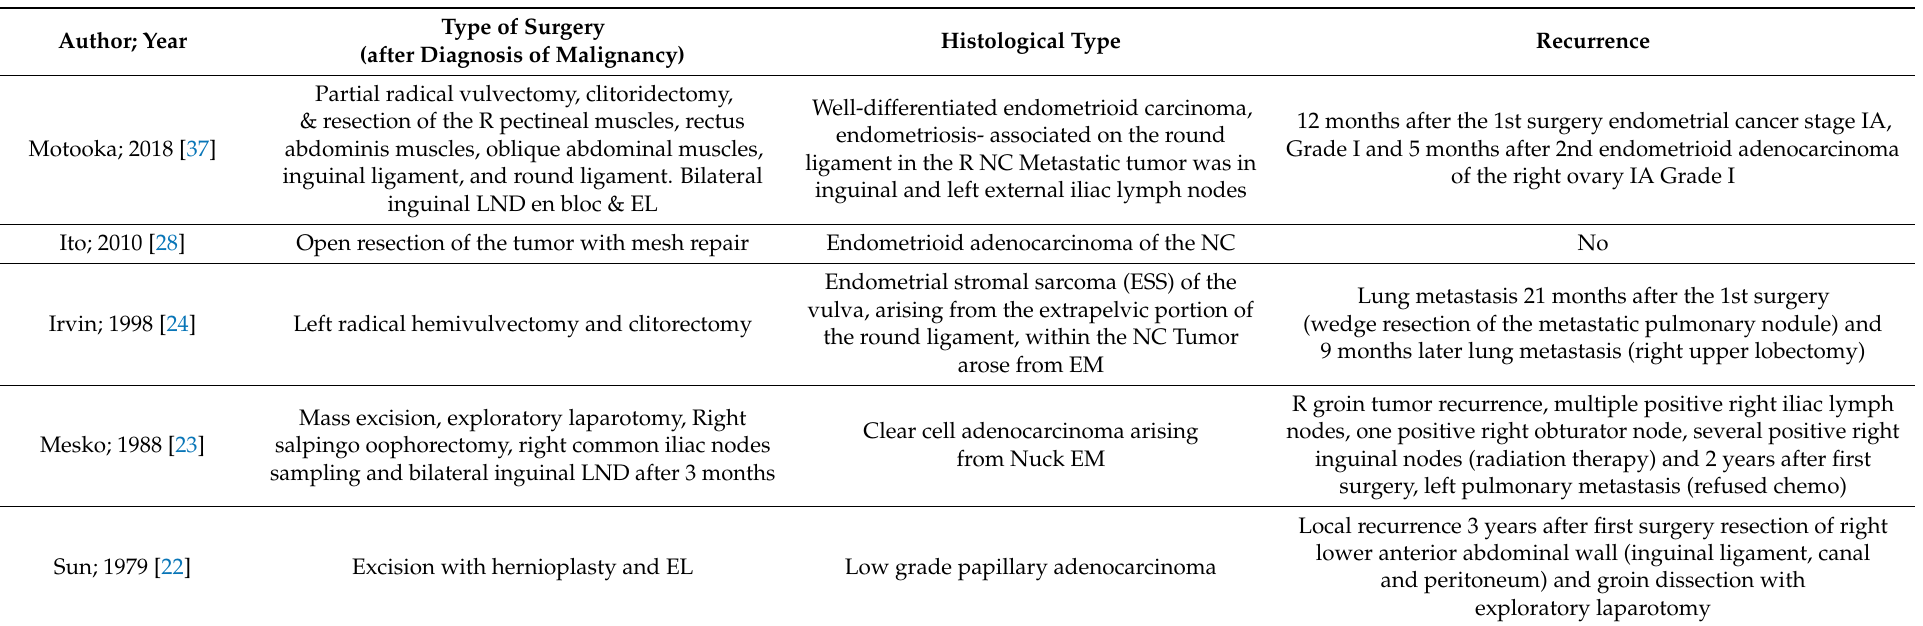
Table 2. Characteristics of studies reporting endometriosis associated Nuck canal